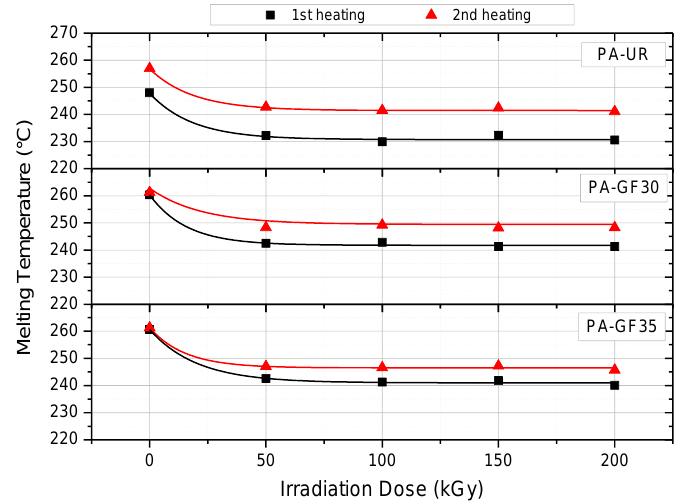
Figure 3. Melting peak temperature T m,p as a function of irradiation dose of three different PA grades for the first and second heating run.